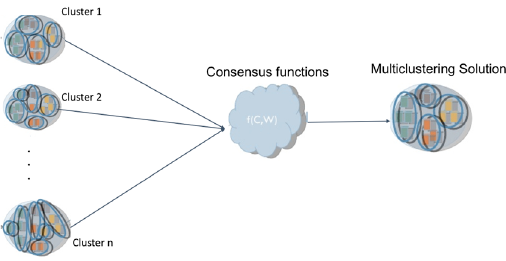
Figure 14. Multiclustering application architecture.